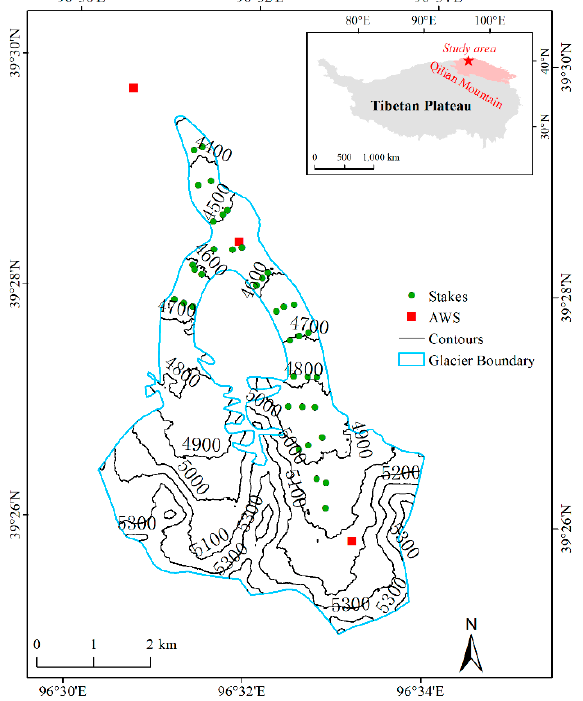
Figure 1. The extent of Laohugou Glacier No. 12 (LHG12) and the location of AWS and stakes, the embedded rectangle displays the positions of LHG12 (red star) and Qilian Mountain Range (pink area) on the Tibetan Plateau.